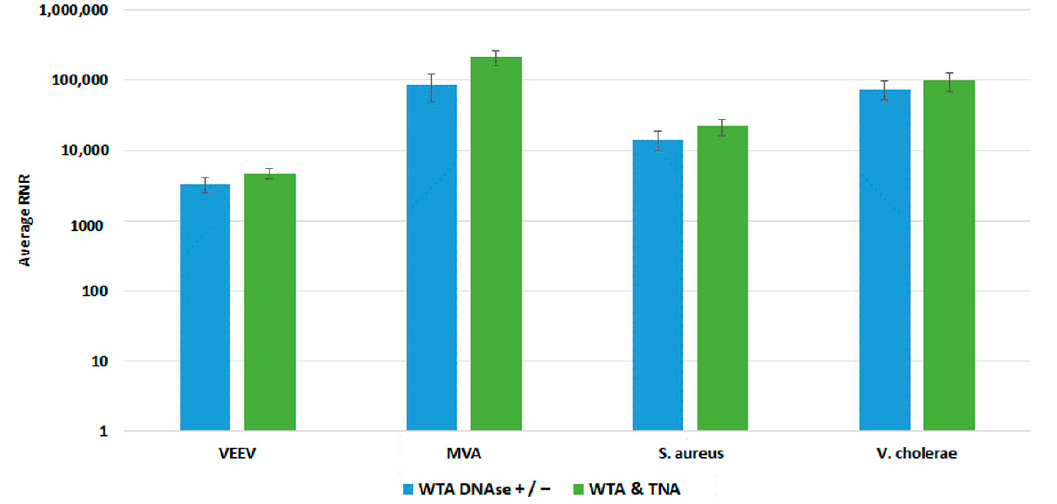
Figure 8. Comparison of WTA Methods, Clinical Workflow. This figure compares RNR values for spiked targets in samples prepared from two different WTA methods. Sequencing libraries pre-